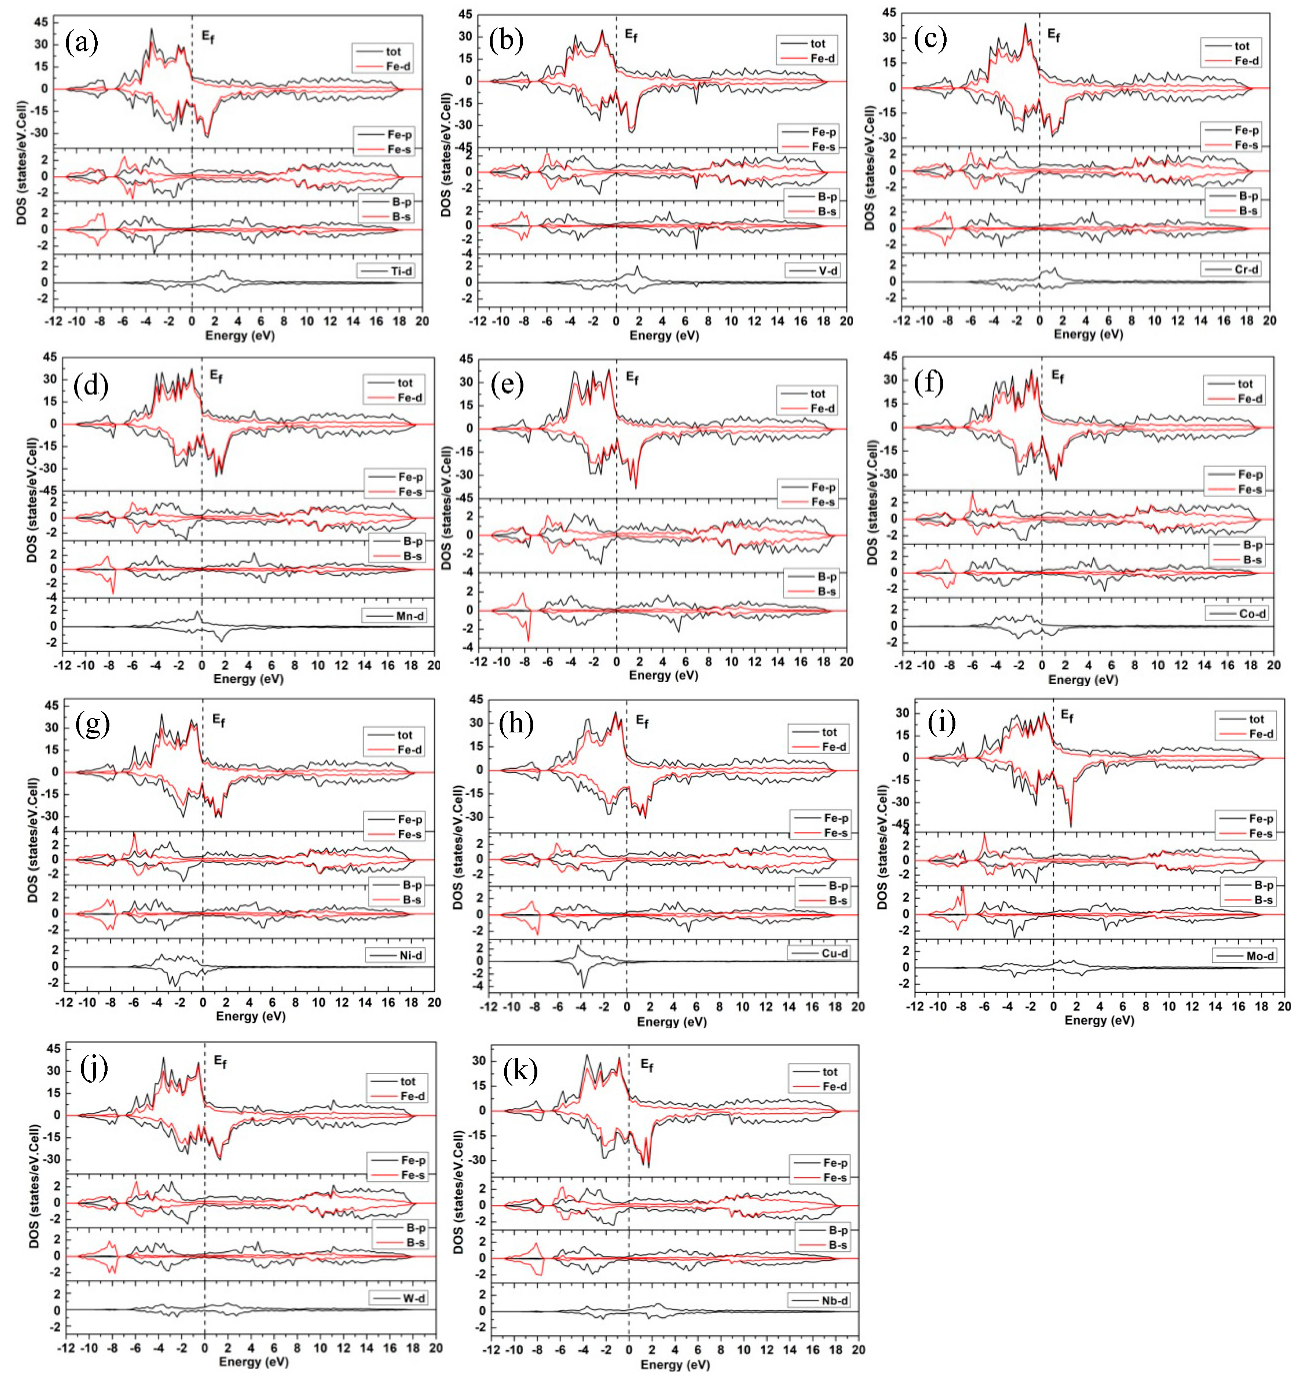
Figure 5. Total density of states (TDOSs) and partial density of states (PDOSs) of ( a ) (Fe 2.875 ,Ti 0.125 )B, ( b ) (Fe 2.875 ,V 0.125 )B, ( c ) (Fe 2.875 ,Cr 0.125 )B, ( d ) (Fe 2.875 ,Mn 0.125 )B, ( e ) Fe 3 B, ( f ) (Fe 2.875 ,Co 0.125 )B, ( g ) (Fe 2.875 ,Ni 0.125 )B, ( h ) (Fe 2.875 ,Cu 0.125 )B, ( i ) (Fe 2.875 ,Mo 0.125 )B, ( j ) (Fe 2.875 ,W 0.125 )B and ( k ) (Fe 2.875 ,Nb 0.125 )B.